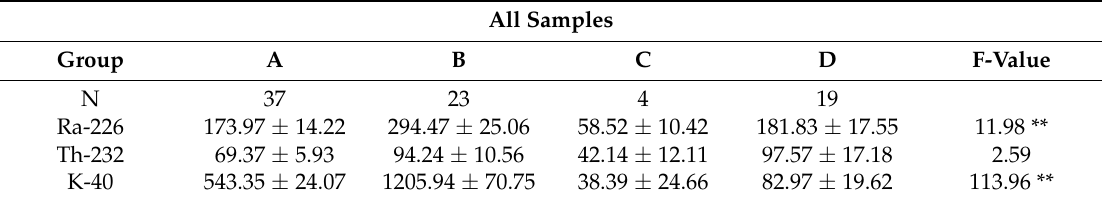
Table 3. Mean values with ANOVA table for the radioactive components in the groups (A–D) of Assiut Governorate water.